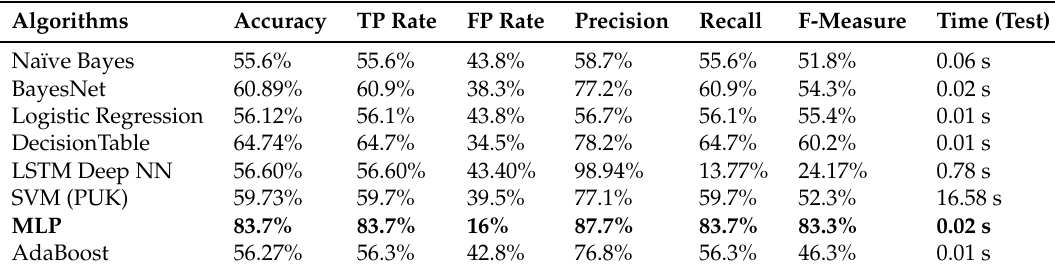
Table 9. Performance evaluation for attack scenario 6.